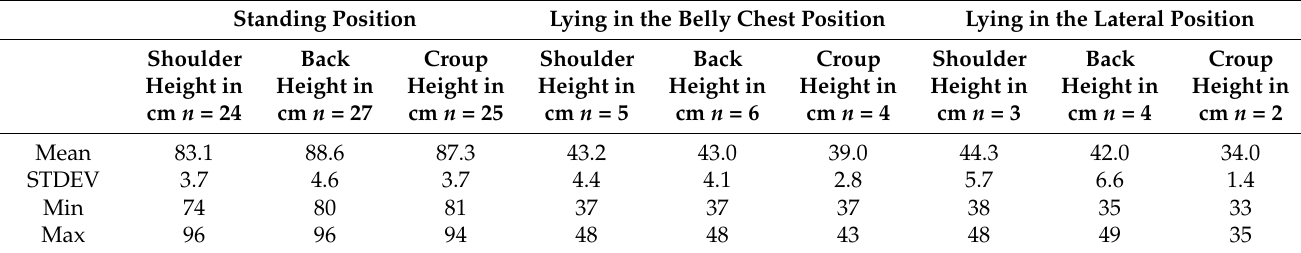
Table 3. Shoulder-, back-, and croup heights (cm) of standing and lying sows from the study population (with STDEV = Standard Deviation, Min = minimal value, Max = maximal value).